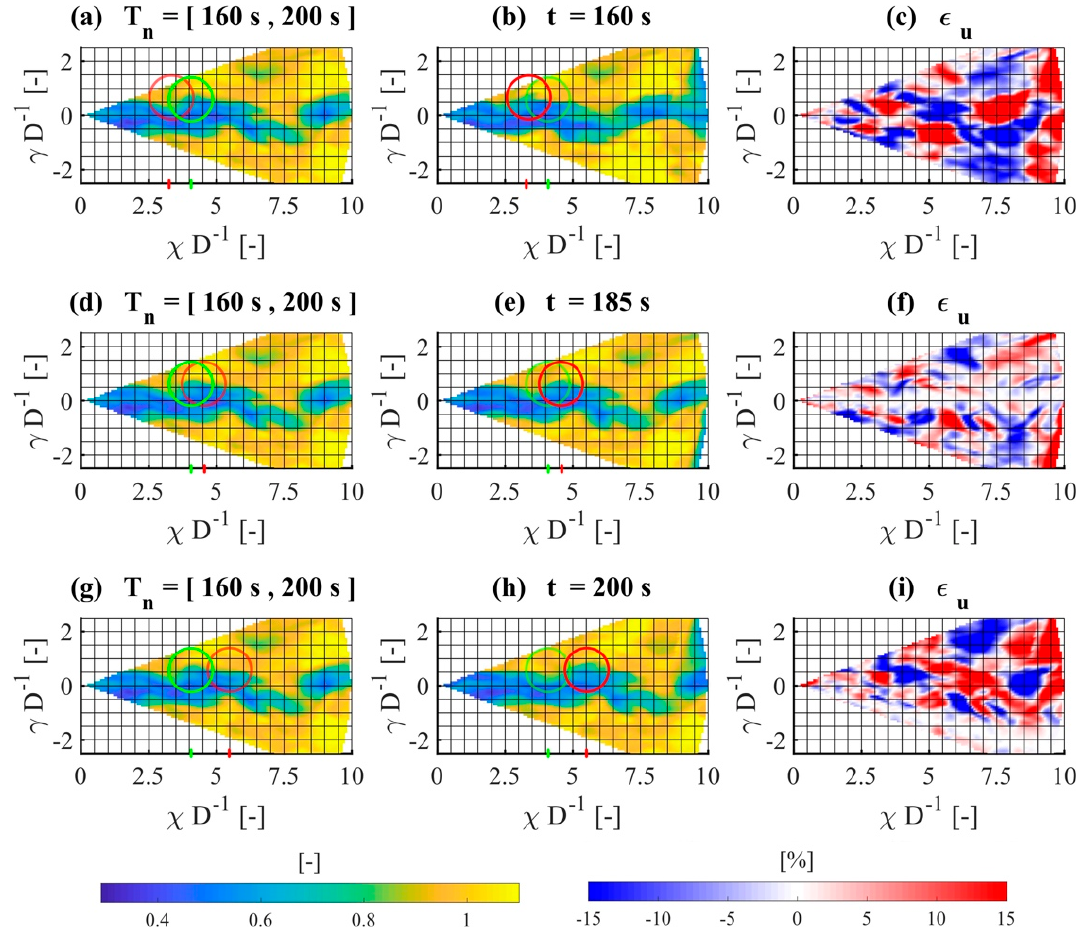
Figure 6. Example of the temporal correction for a time shift with a PPI scan. The first column ( a , d , g ) shows the original LiDAR scan in the time interval, T n = [ 160 s, 200 s ] . The second column ( b , e , h ) shows the temporal improved and corrected data at ( b ) t = 160 s, ( e ) t = 185 s, and ( h ) t = 200 s. The third column ( c , f , i ) illustrates the instantaneous wind-speed deviations of the data in the first and second columns. The green circles mark the characteristic wake structure within the original PPI scan. The red circles indicate the propagated position of the same characteristic wake structure within the time-aligned data at the defined time points.